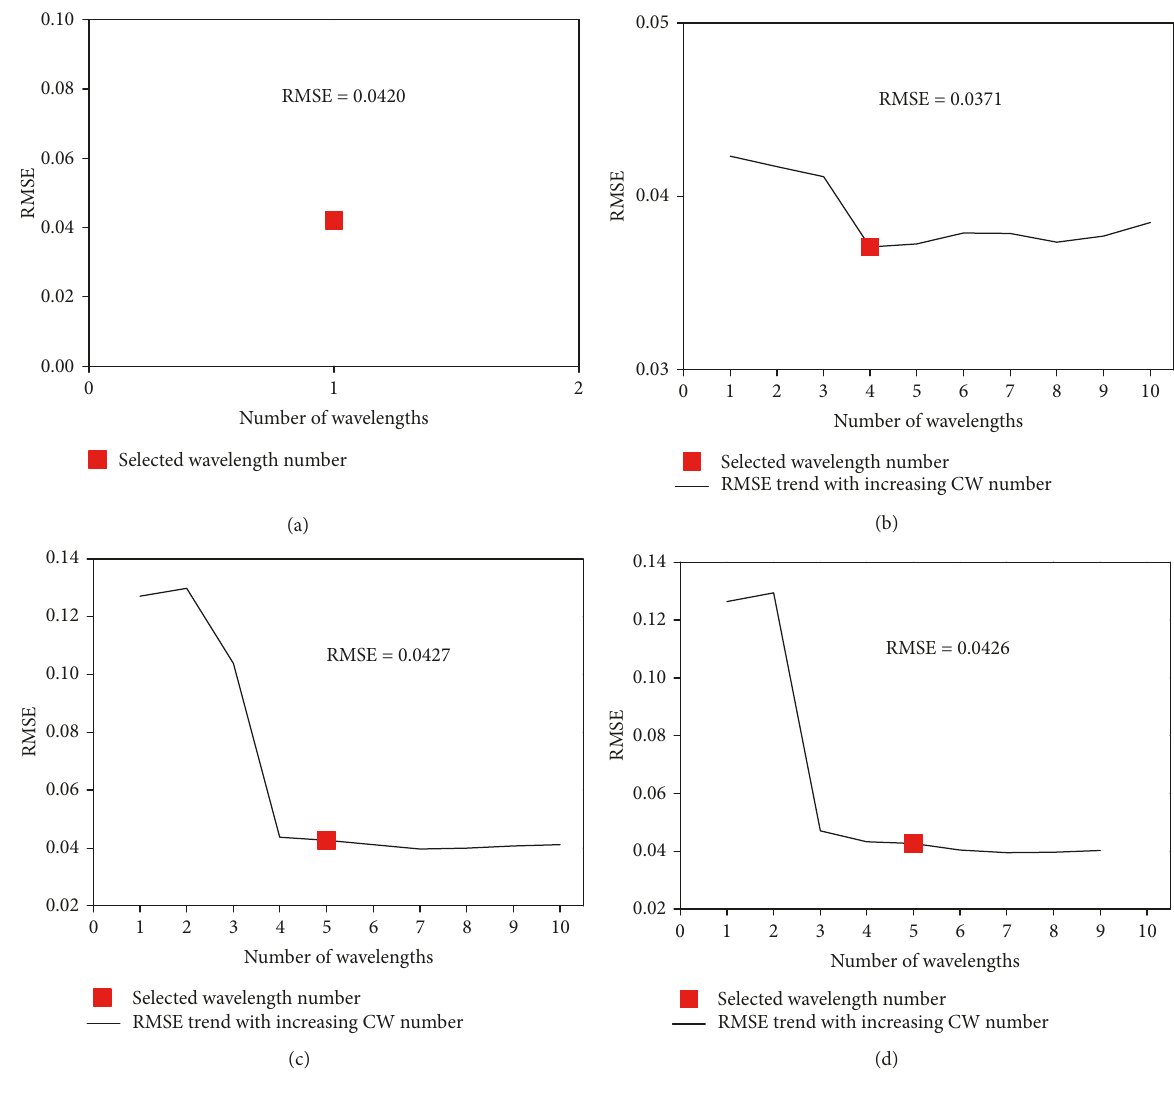
Figure 3: RMSE plot by SPA for no preprocessing (a), SG (b), MSC (c), and MSC-SG